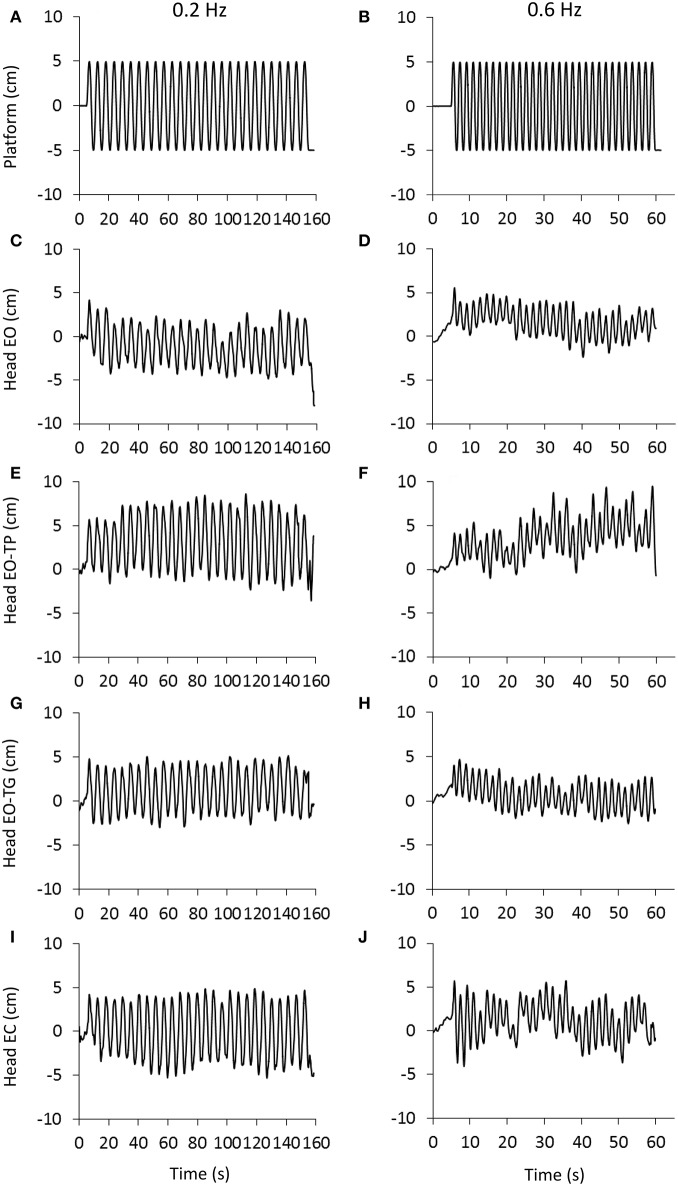
Head displacement under the different visual and perturbation conditions. (A,B), platform translation at 0.2 Hz (left) and 0.6 Hz (right).The platform started to move at t = 5 s and delivered 27 (A) and 31 (B) consecutive translation cycles with a constant amplitude of 10 cm. (C–J): head displacement (marker placed on the head vertex) recorded in a representative subject under eyes open condition (EO, C,D), reading a text printed on a sheet moving with the platform (EO-TP, E,F), reading a text fixed to the ground (EO-TG, G,H) and under eyes-closed condition (EC, I,J). Note the difference in time scale between the columns. Increasing values in the ordinate indicate forward movement.